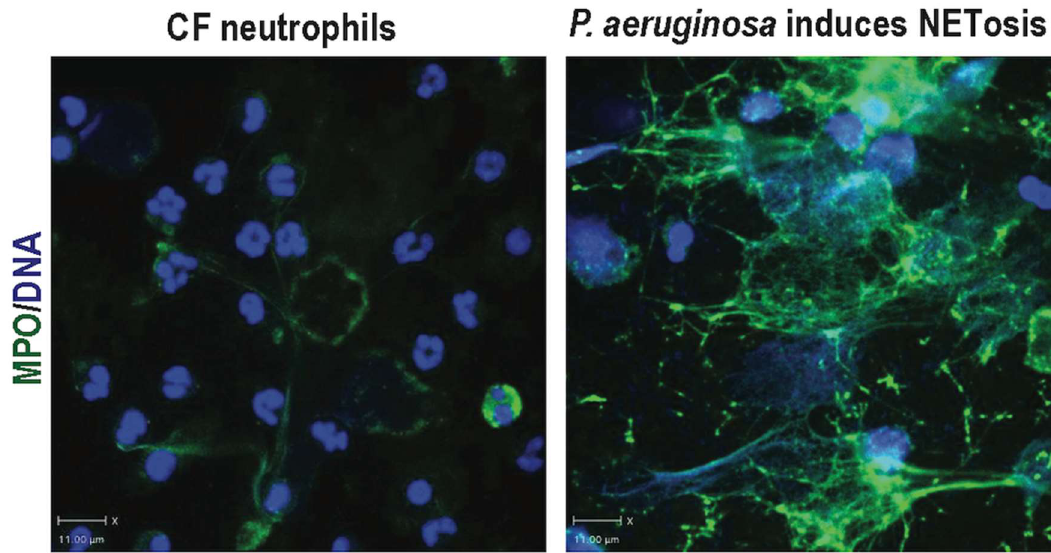
Figure 2. Pseudomonas aeruginosa , induces NETosis in CF neutrophils. Neutrophil purified from patients with CF has typical polymorphonuclear morphology (blue stain). Upon incubation of these neutrophils with P. aeruginosa (e.g., multiplicity of infection of 20), CF neutrophils readily release NETs-DNA (blue stain) coated with granular proteins (e.g., myeloperoxidase; immunostained with green fluorescence antibodies).